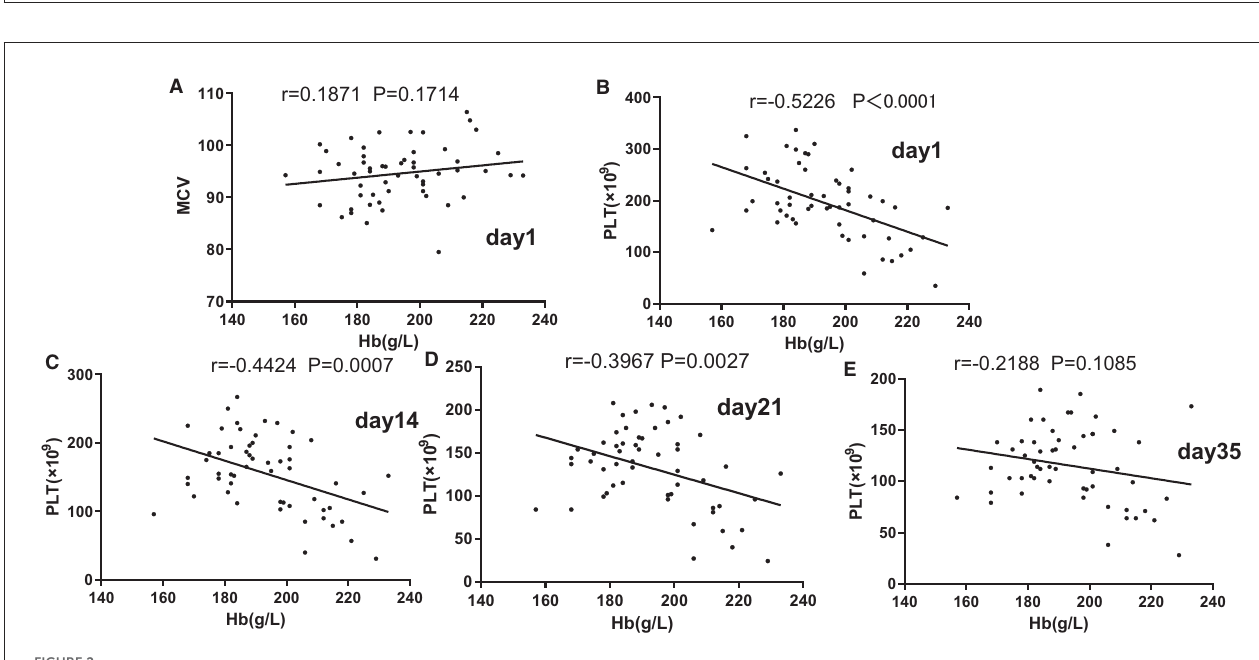
FIGURE2 Associations of mean corpuscular volume (MCV) (A) and Hb and of platelets (PLT) and Hb on days 1 (B) , 14 (C) , 21, and (D) 35. (E) Pearson’s partial correlation analysis was used.